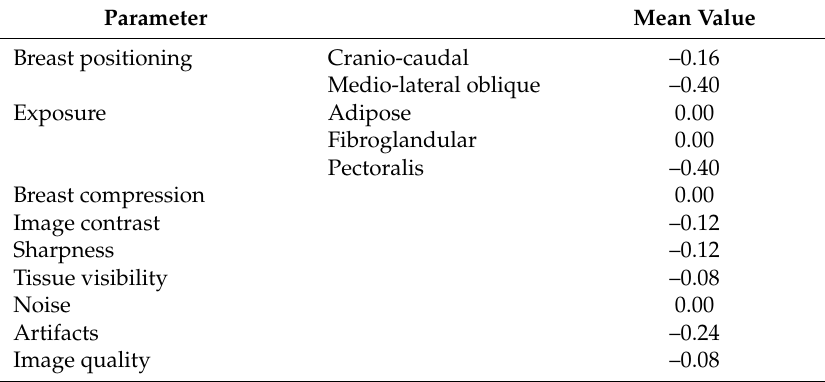
Table 2. Mean values for the 25 subjects (14 healthy volunteers and 11 patients), including age, the time taken by the radiographer with each subject in the image acquisition room, and the 12 FFDM parameters as assessed by our radiologist (K.P.) according to the FDA guidelines [26].